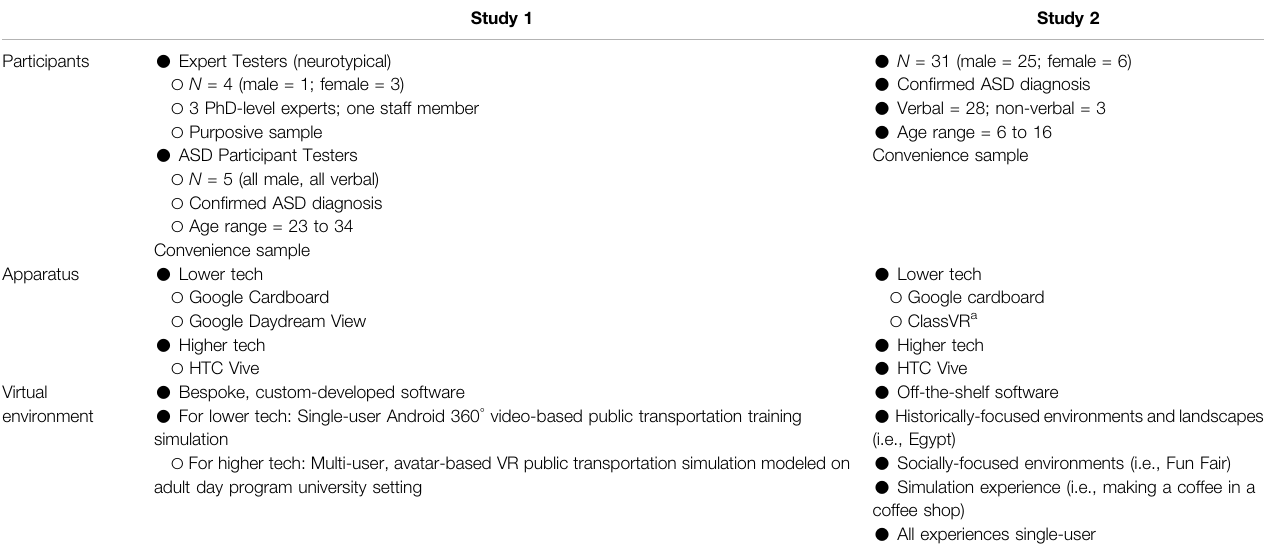
TABLE 1 | Outcomes of Phase 1: Results from analysis of studies (equipment, participants, and virtual